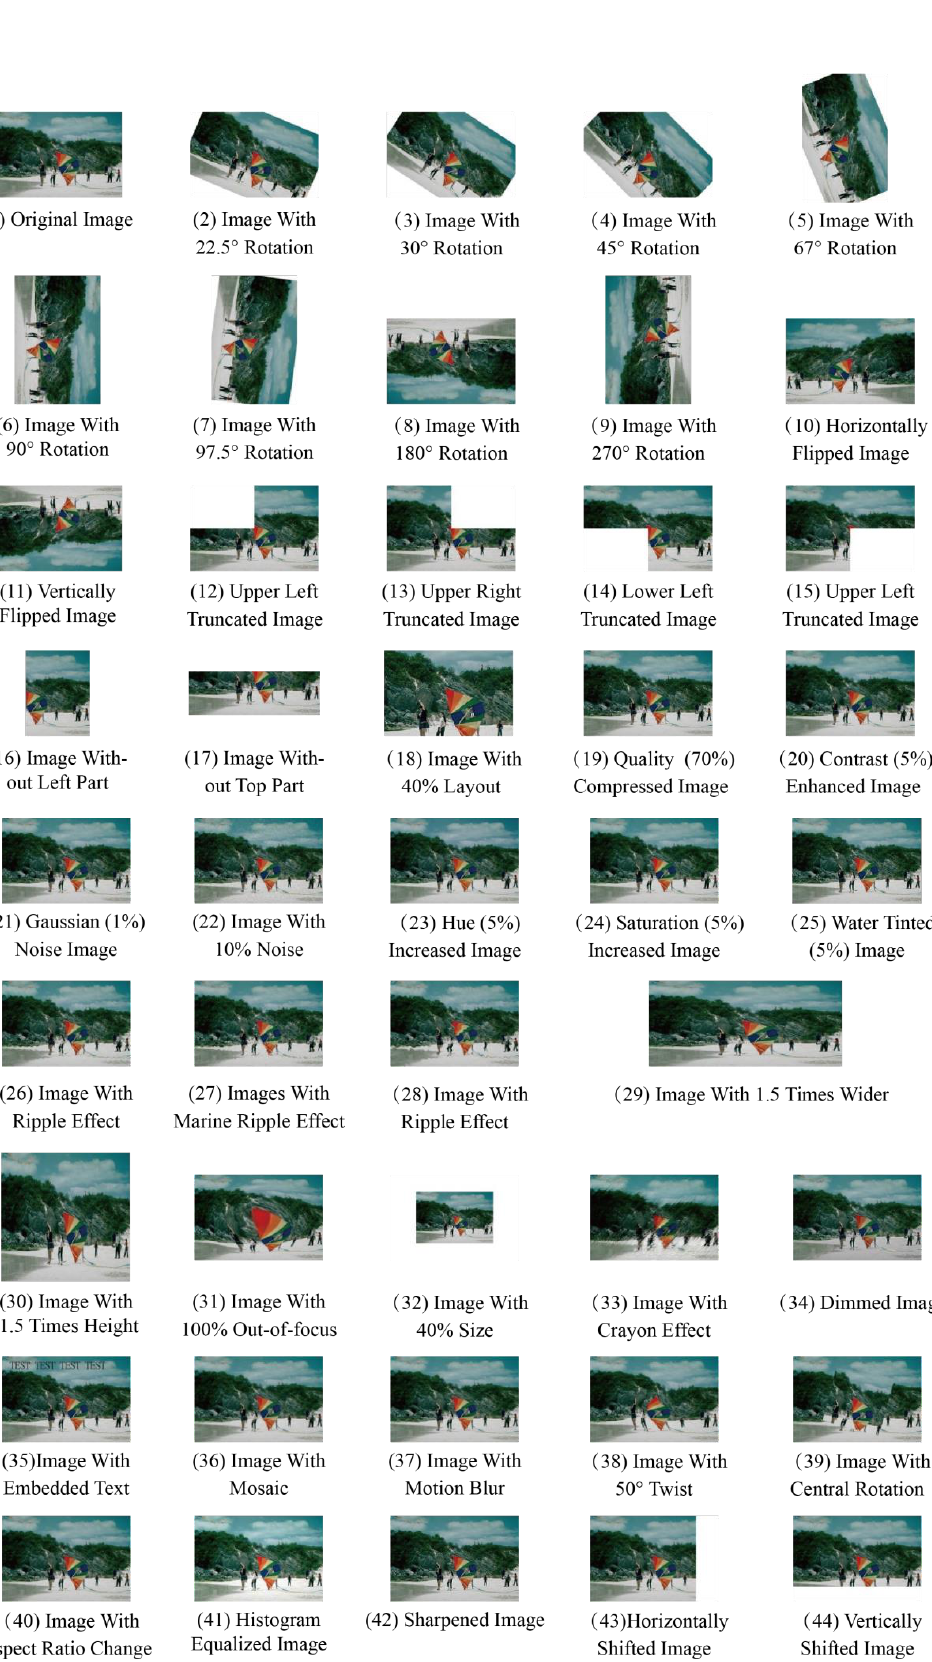
Figure 8. Digital images with different image processing manipulations.